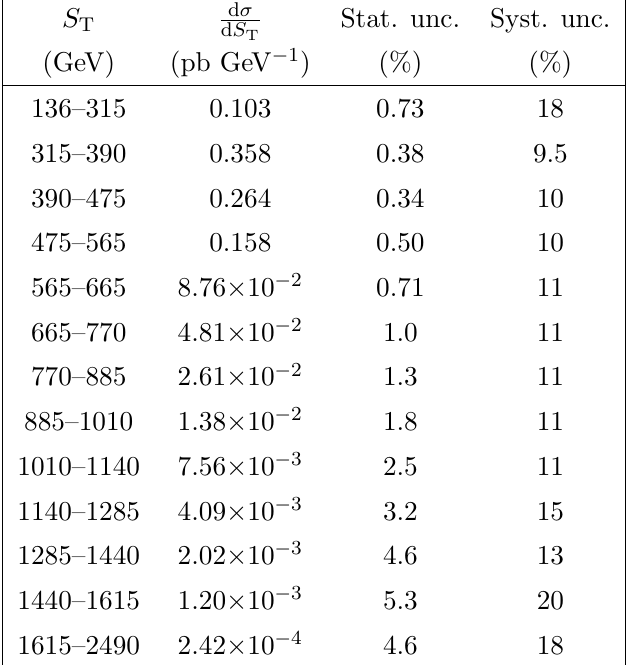
Table 13 . Results of the absolute di(cid:11)erential cross sections with relative uncertainties in the combined channel with respect to S T .